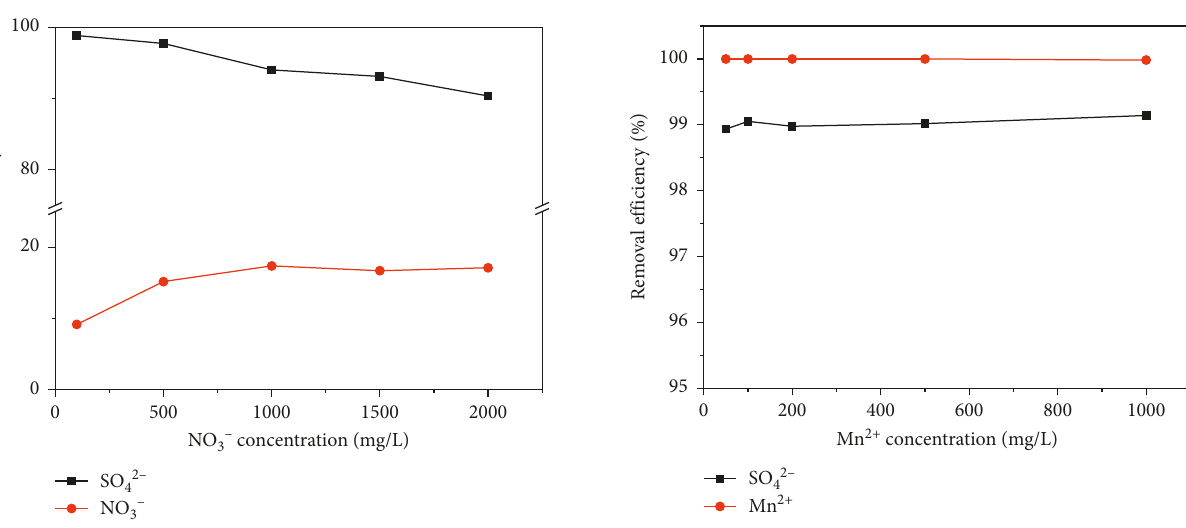
concentration. V solution 3 200r/min, t 30min, T − (cid:27) (cid:27)